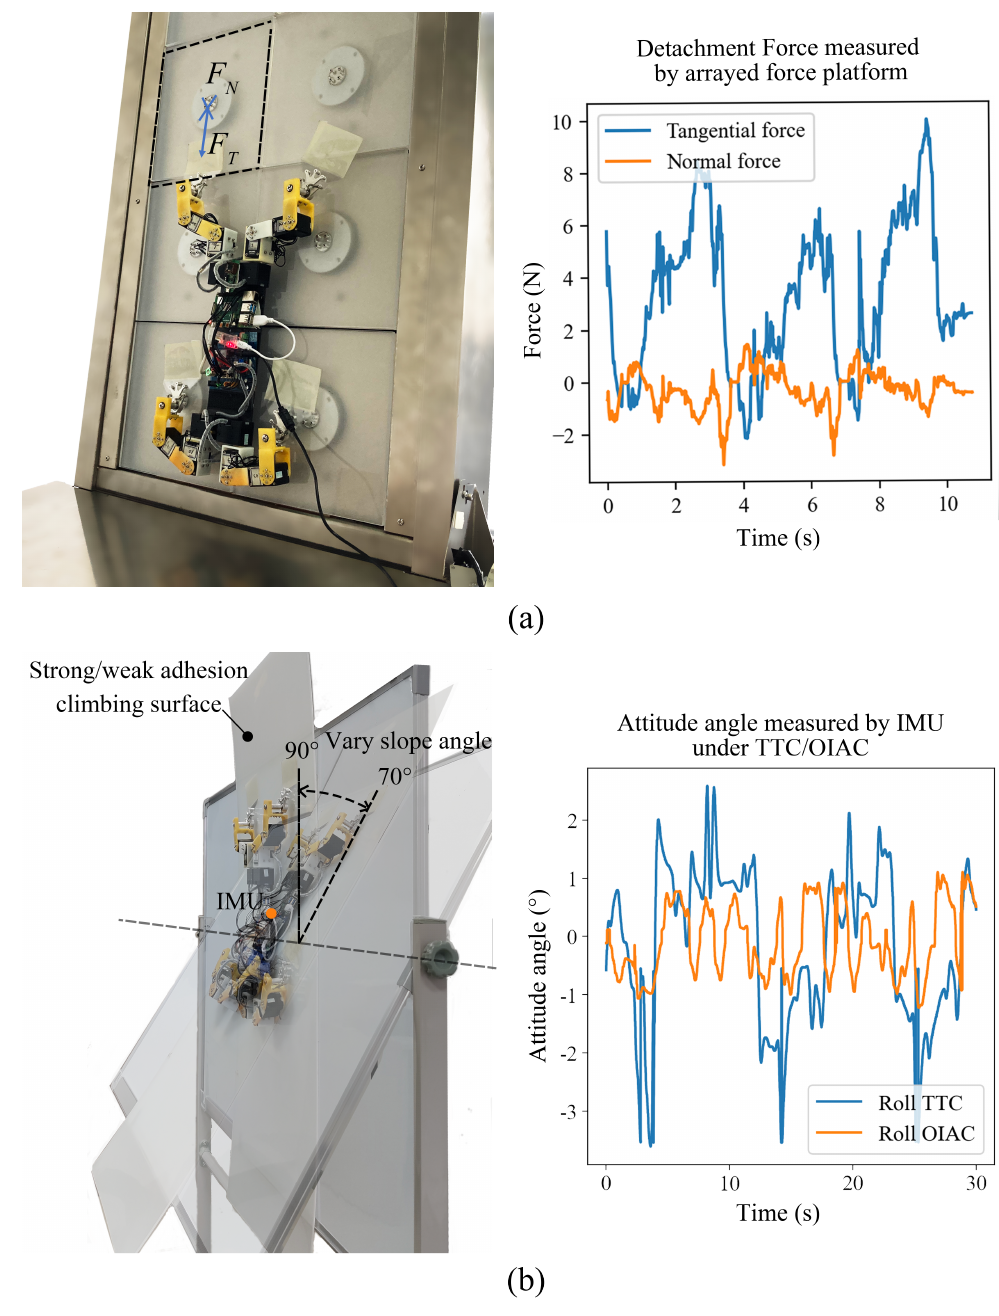
Figure 5. ( a ) Force-time data of one motion period measured by force platform ( F T represents tangential force, F N represents normal force). ( b ) IBSS–8 with trajectory tracking control (TTC) and online impedance adaptive control (OIAC), respectively, climbed the platform and the attitude angle was